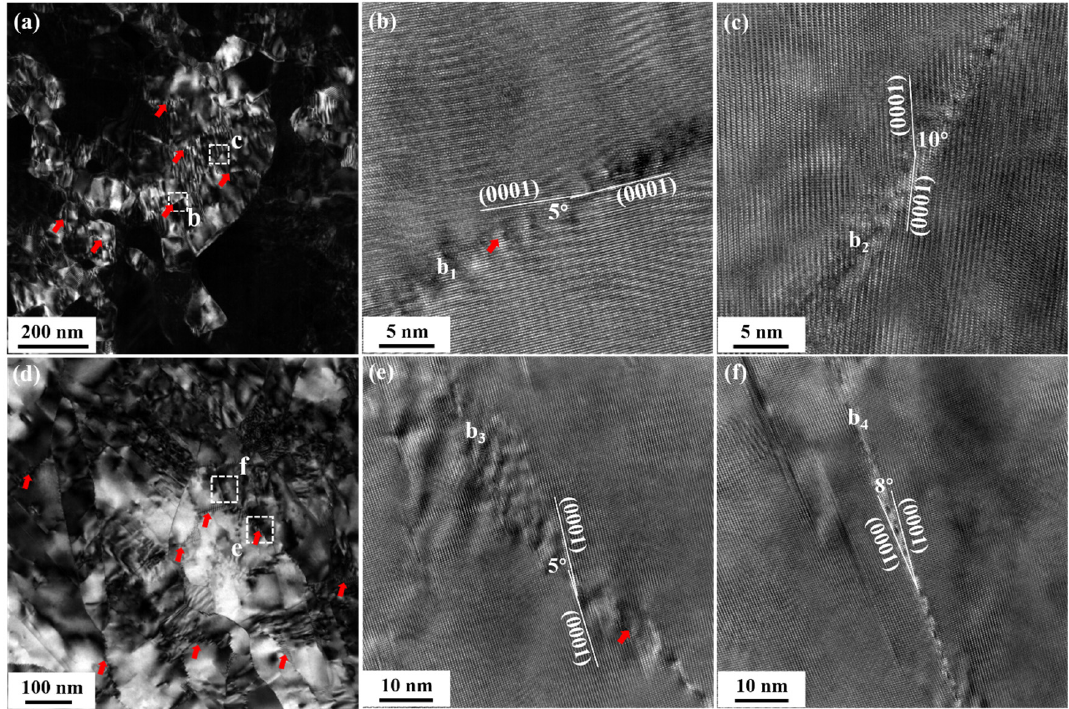
Figure 11. ( a ) TEM dark-field image of the HS-2 sample, showing the segmentation of the twin lamellae by the formation of massive dislocation arrays (red thick arrows); ( b , c ) magnified HRTEM images of the white dotted boxes “b” and “c” in ( a ), respectively; ( d ) TEM bright-field image of the E25S-2 sample, showing massive dislocation arrays also formed within the twin lamellae; ( e , f ) magnified HRTEM images of the white dotted boxes “e” and “f” in ( d ), respectively.